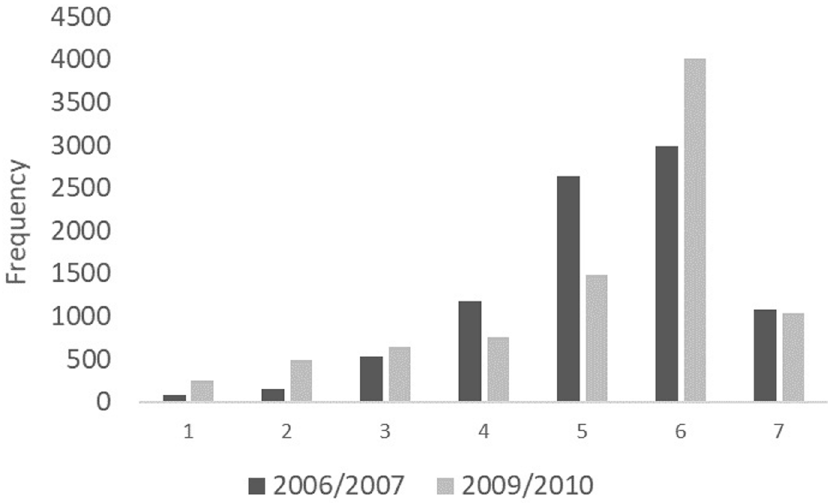
Fig 1. A histogram of life satisfaction in 2006/07 and